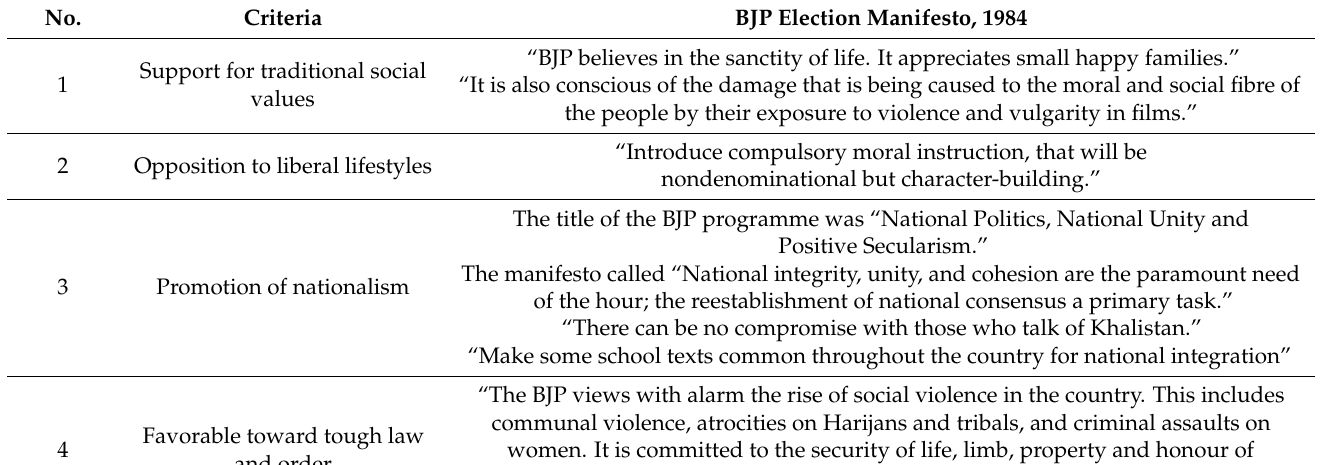
Table 4. Hindu nationalism and populism in Bharatiya Janata Party based on 1984 manifesto (BJP